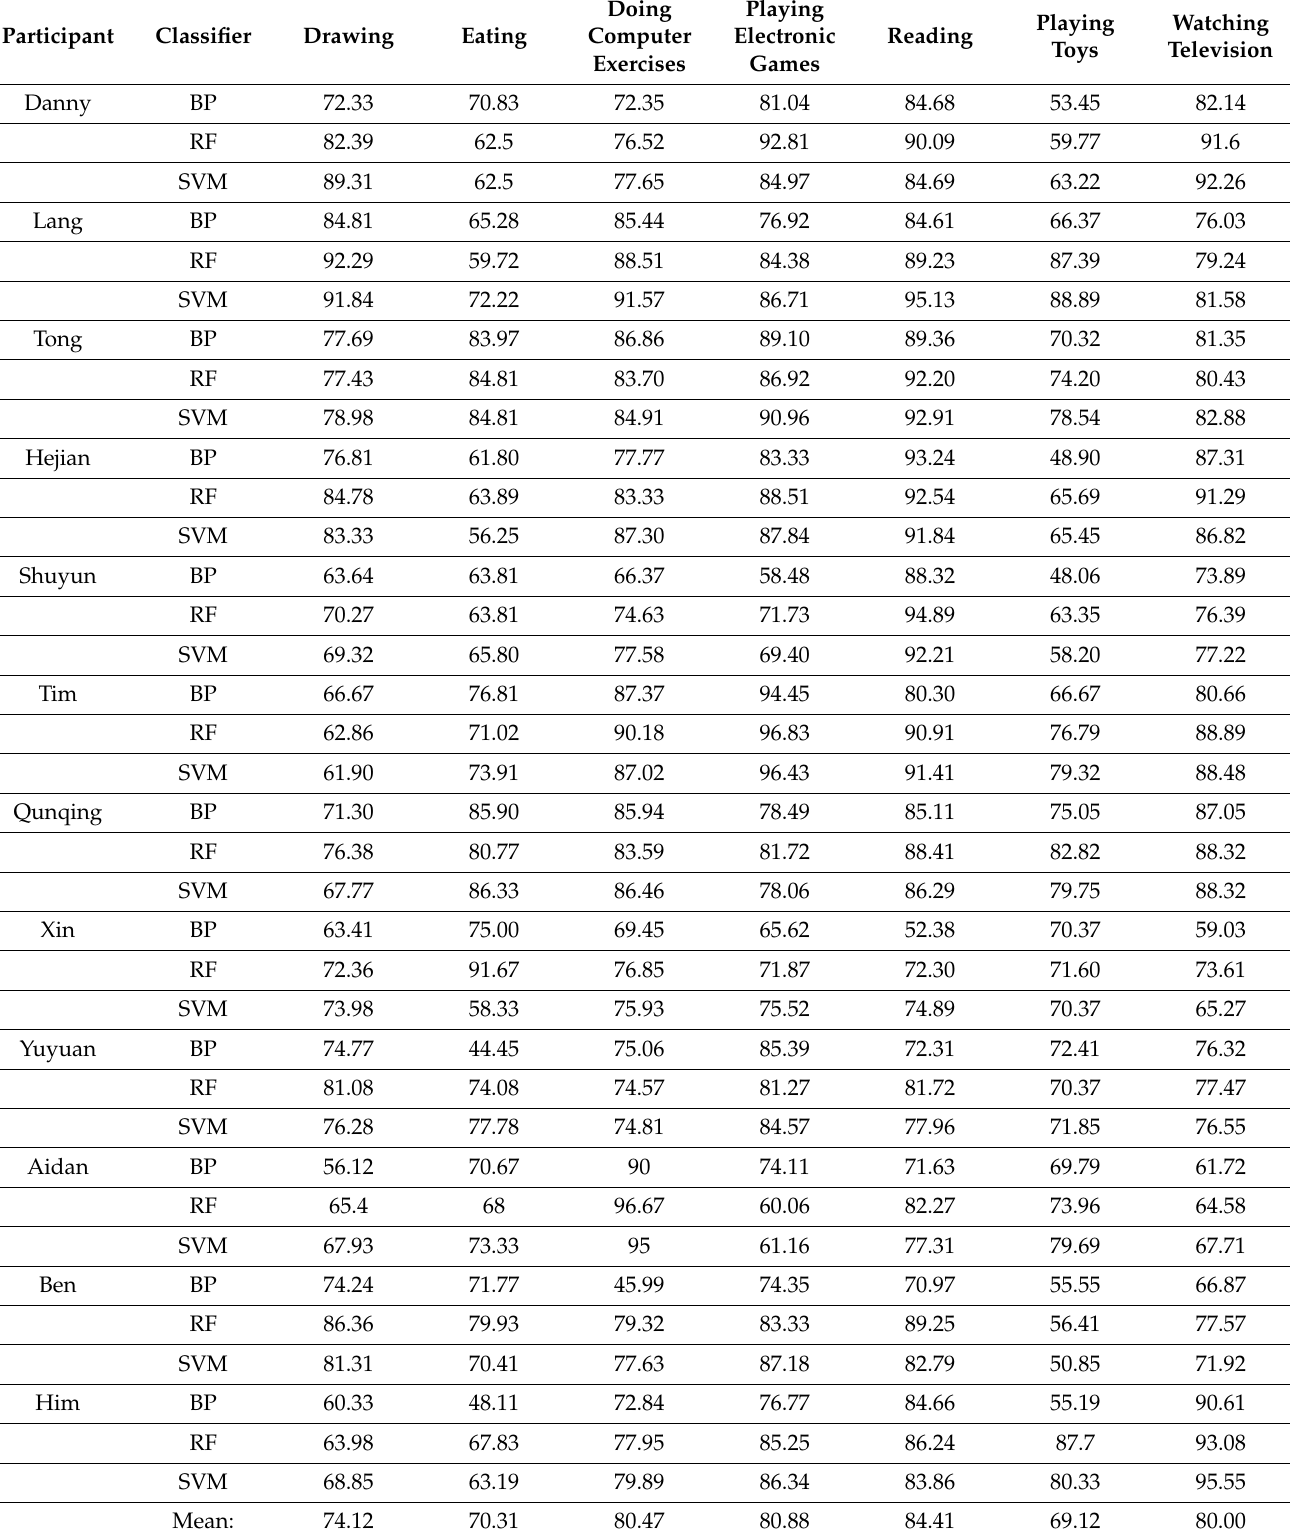
Table 6. The percentages of the classification accuracies for 12 participants performing the various activities under the immersion state via yielded by the traditional